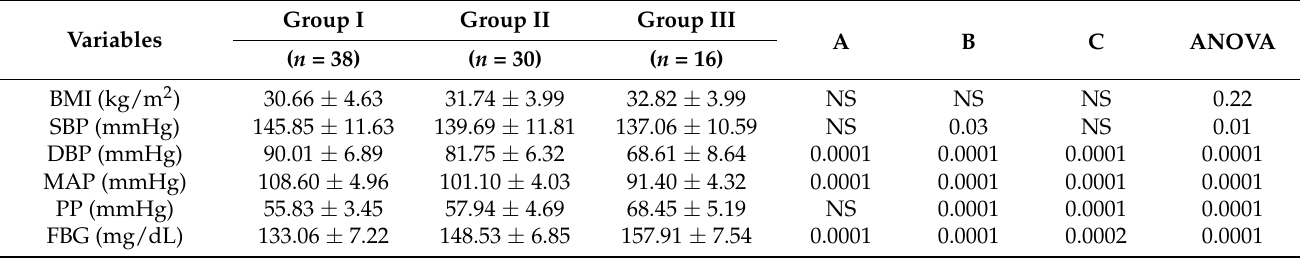
Table 2. Impacts of metformin plus sitagliptin on the anthropometric and biochemical variables in T2DM patients with COVID-19 compared to T2DM